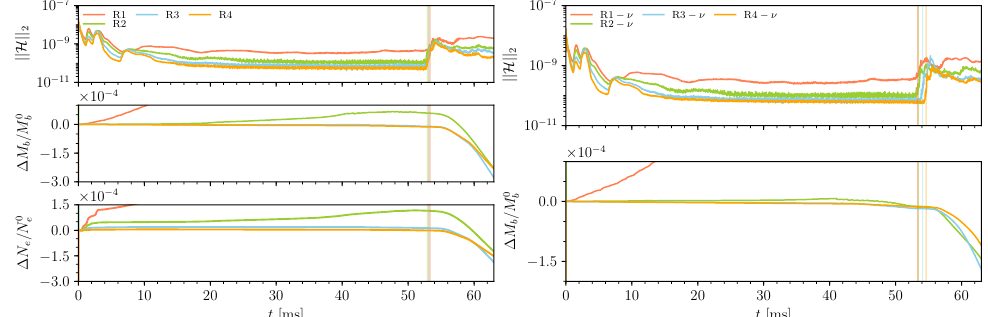
Figure A1. Constraint evolution and conserved quantities. Left panel: BHB Λ φ . Right panel: BHB Λ φ - ν . We show the L 2 norm of the Hamiltonian constraint ||H|| 2 , the baryonic mass variation ∆ M b / M 0 and the electrons number variation ∆ N e / N 0 e for the BHB Λ φ (left panel) for all four resolutions of Table 2. We observe good behavior of the Hamiltonian constraint and conserved quantities with increasing resolution in both cases. Physical quantities were extracted from the grid level l = 1, and the vertical lines mark the merger for each